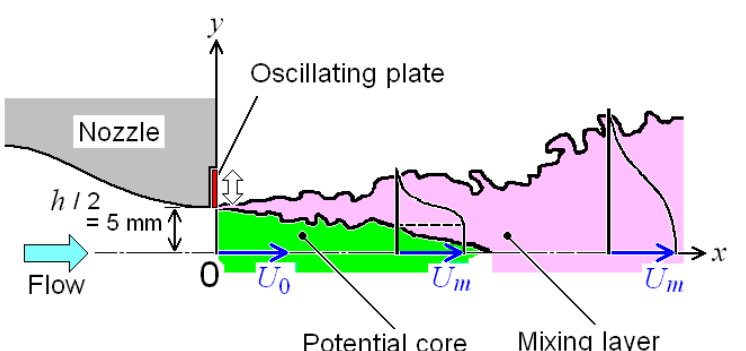
Fig. 1 Schematic diagram of two-dimensional mixing layer and coordinate system. Velocity profiles in the figure show the ones where the vertical lines